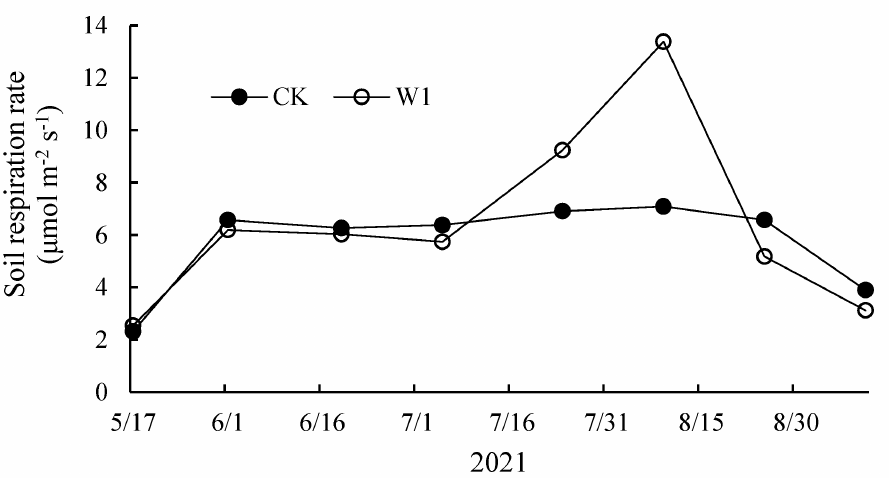
Figure 1. Variation of soil respiration rate of millet farmland under supplemental irrigation and rainfed conditions during the whole period.